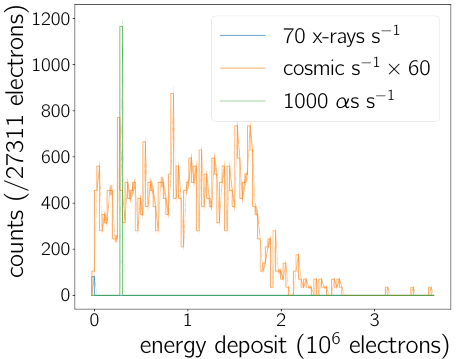
Figure 8. The simulated energy deposits of 241 Am decay radiation and cosmic muons inside a gas volume filled with Ar/CO 2 (90/10). Energy deposits are measured in the number of liberated electrons during the energy deposit. This is the result of a HEED [27] and G ARFIELD ++ [28] study taking the approximate layout of the HPTPC and the information in [25,26] into account.